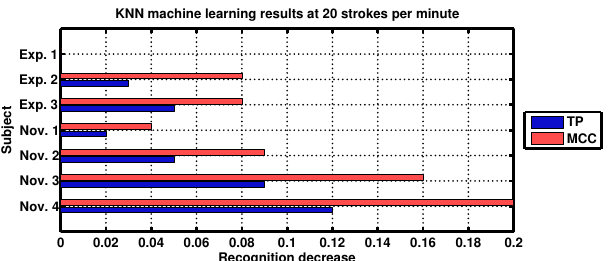
Figure 6: Machine learning results for the KNN classifier at 20 strokes per minute.